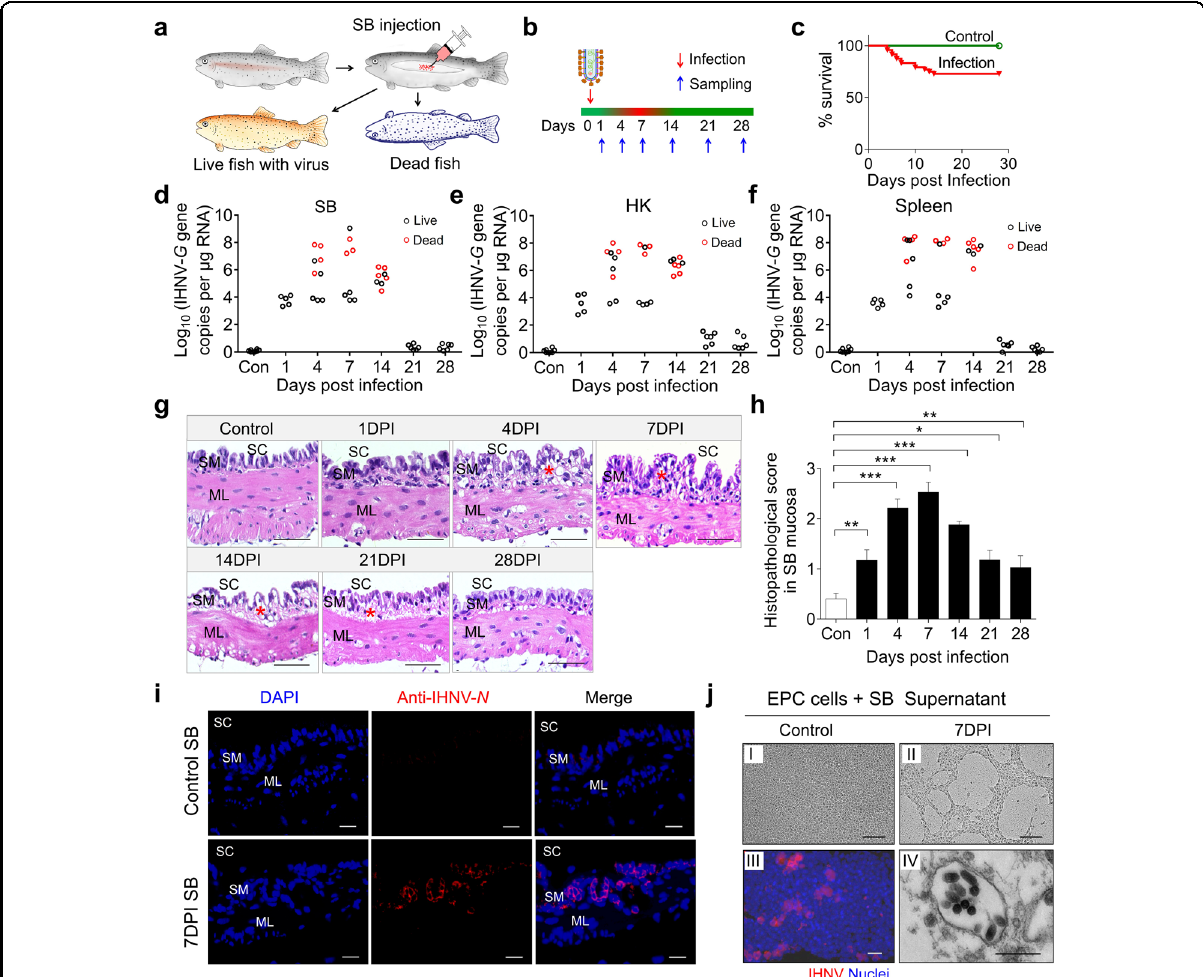
Fig. 2 Infection model of SB with IHNV. a , b Trout were injected with 25 μ L (1 × 10 5 TCID 50 ) of virus solution via intra-SB injection, and subsequently sacri fi ced at 1, 4, 7, 14, 21, and 28 DPI for tissue sample collection. The red color on the timeline represents dead fi sh or diseased fi sh which have symptoms of viral infection (i.e., slow swimming speed and inactive feeding when compared to control fi sh) while the green color represents normal behavior of a healthy fi sh . c Cumulative survival of control and IHNV-infected fi sh. d – f IHNV- G gene copies (Log 10 ) were quanti fi ed using qPCR in fi sh tissues collected at 1, 4, 7, 14, 21, and 28 DPI. The virus was detected in the fi sh SB ( d ), head kidney (HK) ( e ), and spleen ( f ). Each circle represents one fi sh; red circles represent dead fi sh while black circles represent live fi sh. g Histological examination of SB from control fi sh and trout infected with IHNV at 1, 4, 7, 14, 21, and 28 DPI ( n = 5 – 9). Red asterisks indicate the damage in SM. SC SB cavity, SM SB mucosa, ML muscle layer. Scale bars, 50 μ m. h Pathology score of SB mucosa from control and infected fi sh. i Immuno fl uorescence staining of IHNV in SB paraf fi n-sections from control and 7 days infected fi sh ( n = 5 – 11). IHNV (red) is stained with an anti-IHNV- N mAb; nuclei were stained with DAPI (blue). SC SB cavity, SM SB mucosa, ML muscle layer. Scale bars, 20 μ m. j Cytopathic effect of IHNV on epithelioma papulosum cyprini (EPC) cells after culture with the supernatant of SB homogenates from control ( j I ) and the 7-day infected fi sh ( j II ). Immuno fl uorescence staining of IHNV using the anti-IHNV- N mAb, nuclei were stained with DAPI (blue) ( j III ). Electron microscope (EM) analysis of viral particles within EPC cells ( j IV ) from j II . Scale bars, 100 μ m in j I and j II , 20 μ m in j III , 500 nm in j IV . Statistical differences were evaluated by unpaired Student ’ s t -test. Data in h are representative of at least three independent experiments (mean± SEM). * P < 0.05, ** P < 0.01, and *** P <